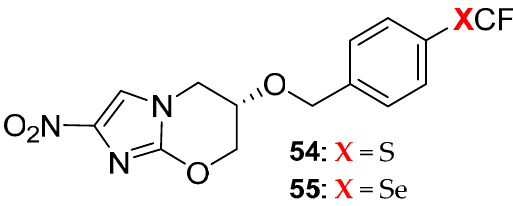
Figure 13. Chalcogen isosteres ( 54 , 55 ) of pretomanid.